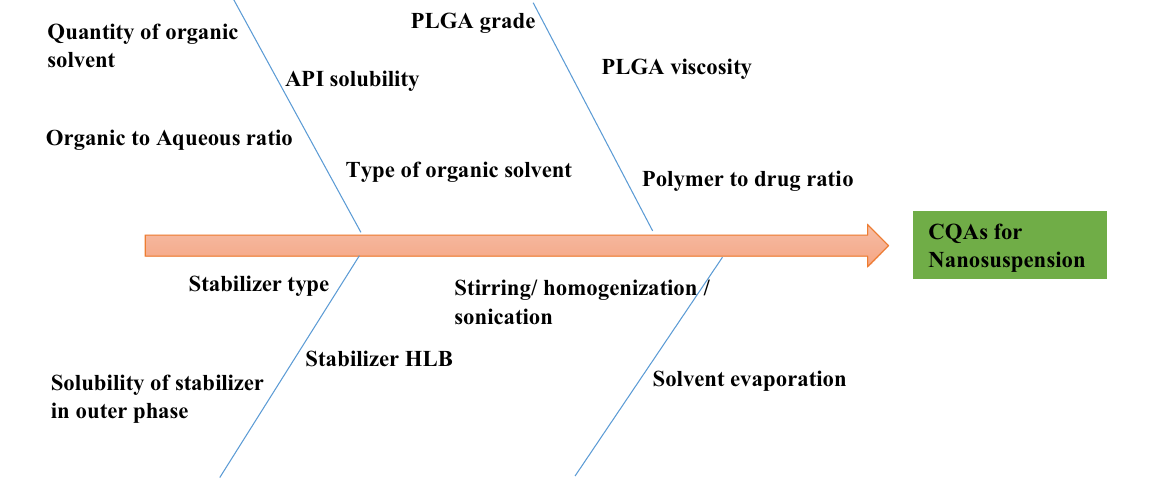
Fig. 6 The fishbone diagram or Ishikawa diagram for QbD prospects of pharmaceuticals application of double emulsion method for PLGA loaded nanoparticles